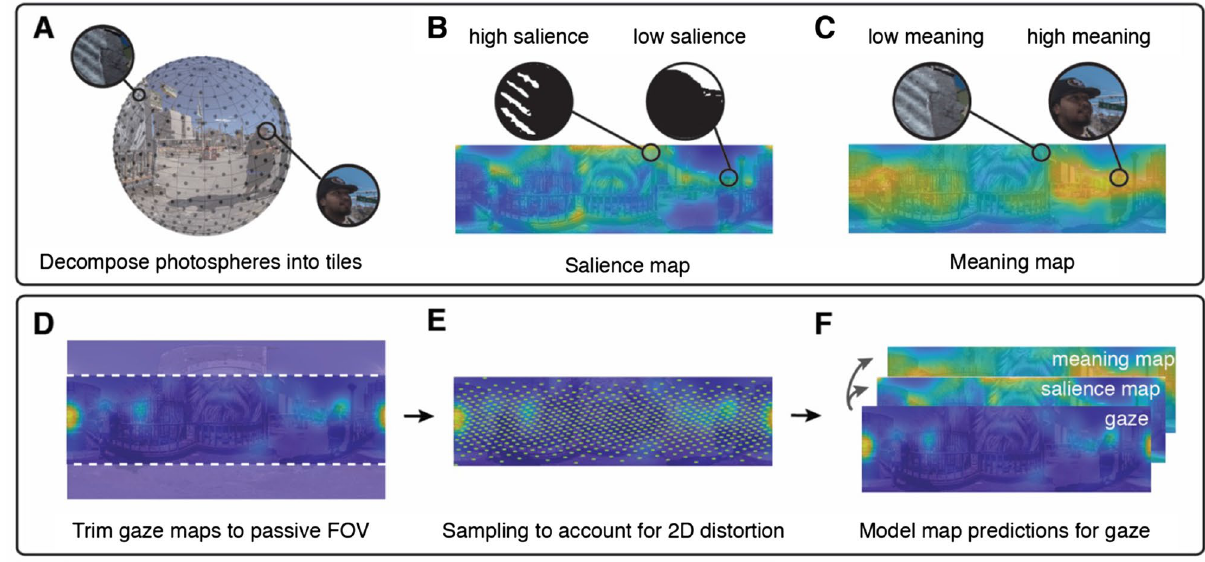
Figure 2. Comparing salience and meaning maps to gaze behavior. ( A ) Each photosphere was first decomposed into smaller undistorted image tiles. Next, we created two models of the content in each real-world environment. ( B ) “Salience maps” were generated by modeling low-level visual features for each tile using the GBVS Toolbox 16 . Each tile was then projected onto a two-dimensional salience map. ( C ) “Meaning maps” were generated via online participants who rated the semantic content, or “meaning” of each image tile. Each tile’s rating was then projected onto a two-dimensional meaning map. ( D ) Group gaze maps were trimmed (vertically) to match the passive condition field of view. ( E ) Points are sampled evenly on a sphere and used to account for photosphere distortion in two-dimensional maps. ( F ) A linear mixed effects model was used to compare the degree to which each model predicted attentional guidance in our two conditions. (Image adapted from Pyramid Oracle Panorama by Nathan Tweti .)